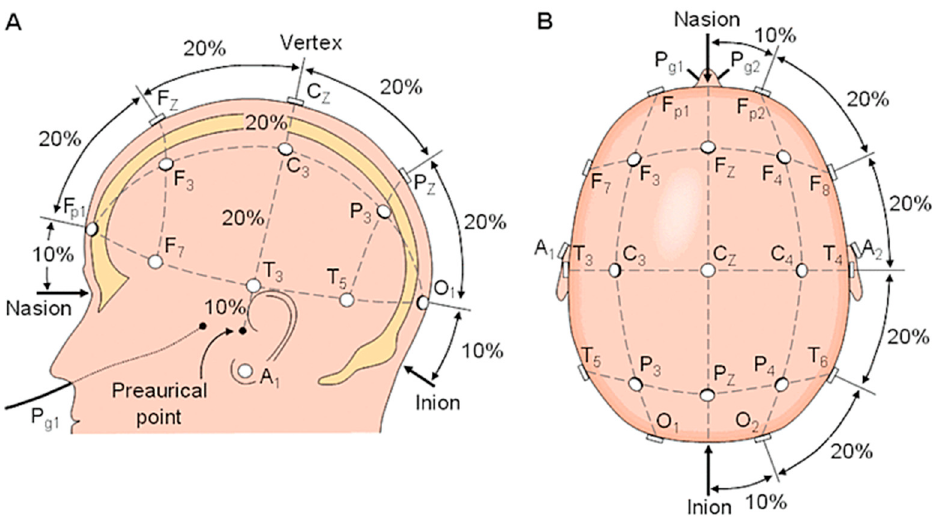
Figure 1. The 10–20 system. ( A ) front side, ( B ) top side [11,12].